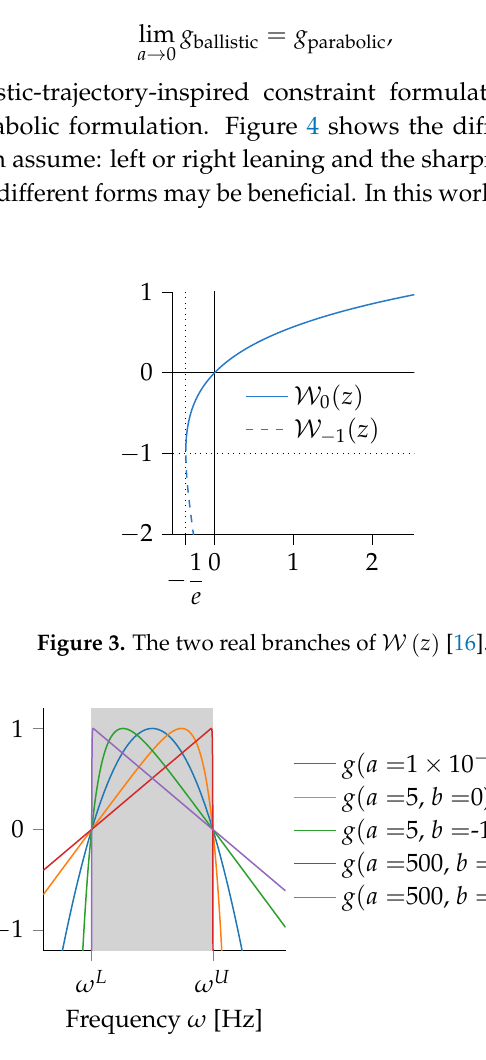
Figure 4. Different profiles of the ballistic range constraint